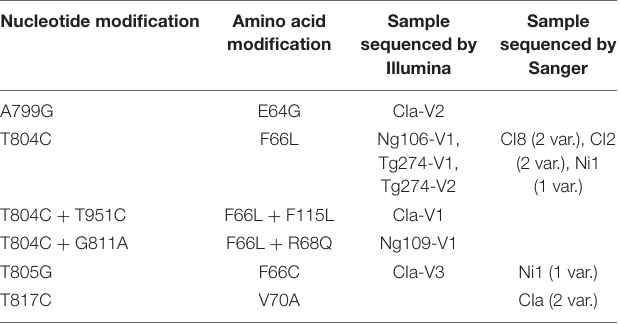
TABLE 3 | Non-synonymous mutations observed in the membrane anchor domain of polyprotein P2a. Nucleotide